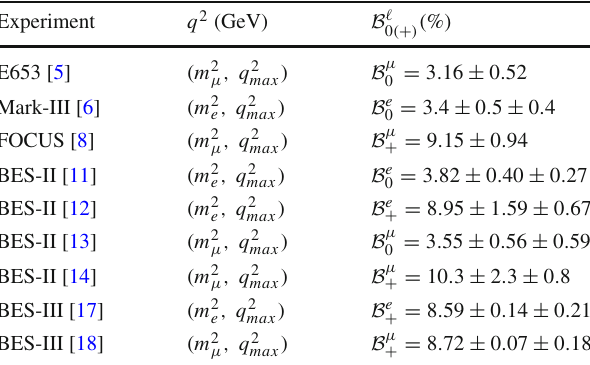
Table 2 Branching fractions B (cid:2) ent experiments